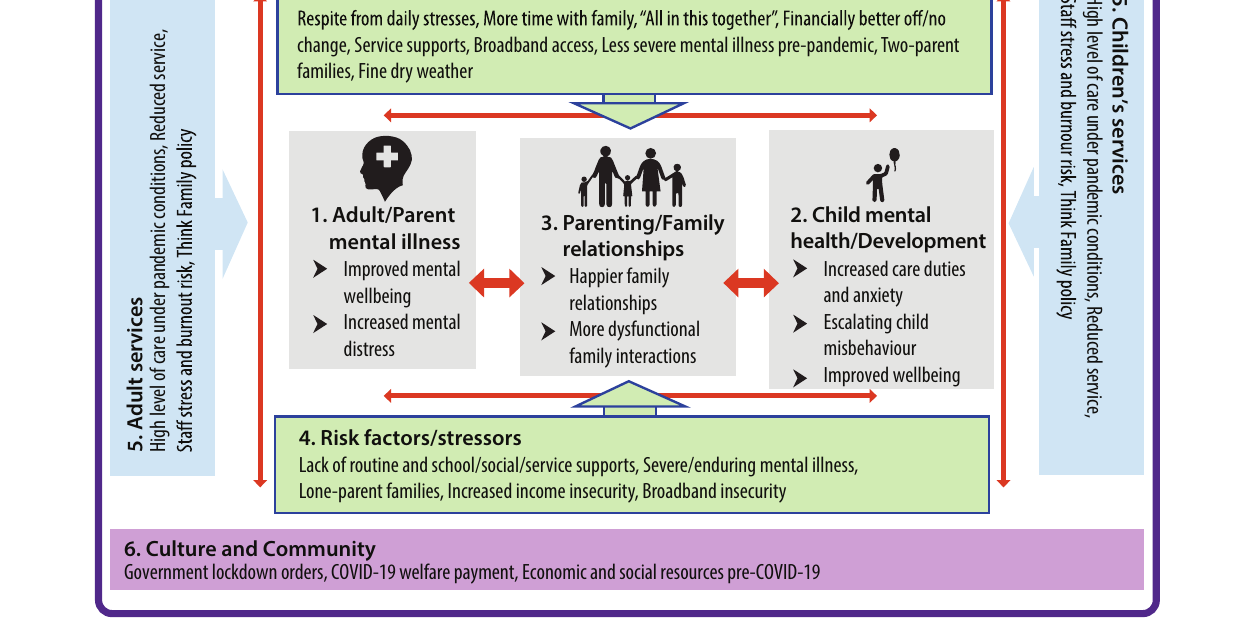
Frontiers in Psychiatry |